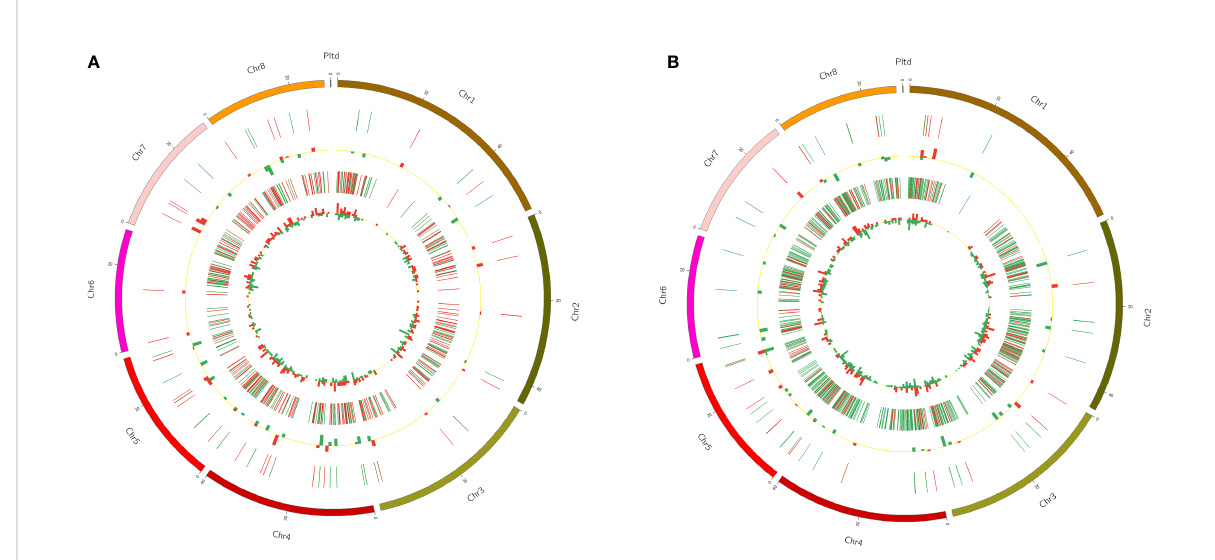
FIGURE 5 The distribution of differentially expressed lncRNAs (DELs) and differentially expressed mRNAs (DEGs) in FC vs FNC (A) and FB vs FC (B) . Among them, the outermost circle is the distribution of pomegranate chromosomes; the second circle is the distribution of DELs on chromosomes, the red line indicates up-regulation, and the green line indicates down-regulation; the third circle is a histogram of DELs at different positions, and red indicates up-regulation, green means down-regulation. The higher the column, the more the number of DELs; the fourth circle is the distribution of DEGs on chromosomes, the color distribution is the same as that of DELs; the innermost circle is the histogram of DEGs at different positions, the color distribution is same as